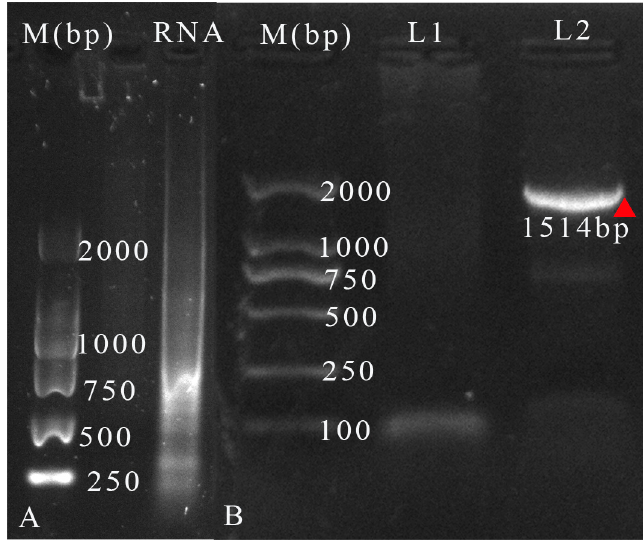
Figure 2. ( A ) Gel electrophoresis of viral RNA, and ( B ) the PCR products obtained from the viral